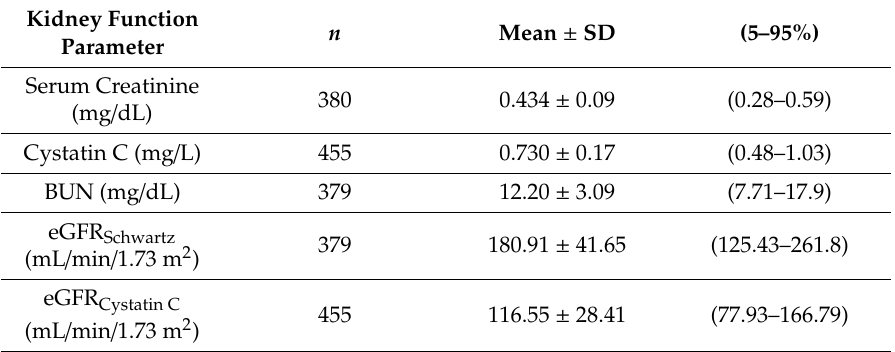
Table 2. Kidney function parameters from 9-year-old